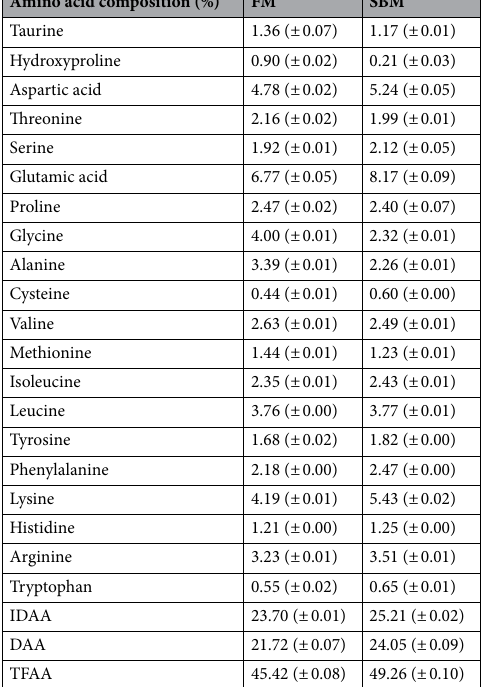
Table 2. Dietary amino acid composition. Diets were analyzed in triplicates. The values presented are the mean (± standard deviation). Indispensable amino acids (IDAA) = Ile, Leu, Lys, Met, Phe, Thr, Trp, Val, Arg, and His. Dispensable amino acids (DAA) = Ala, Asp, Taurine, Glu, Hyp, Gly, Pro, Ser, Cys, and Tyr. TFAA total free amino acids.